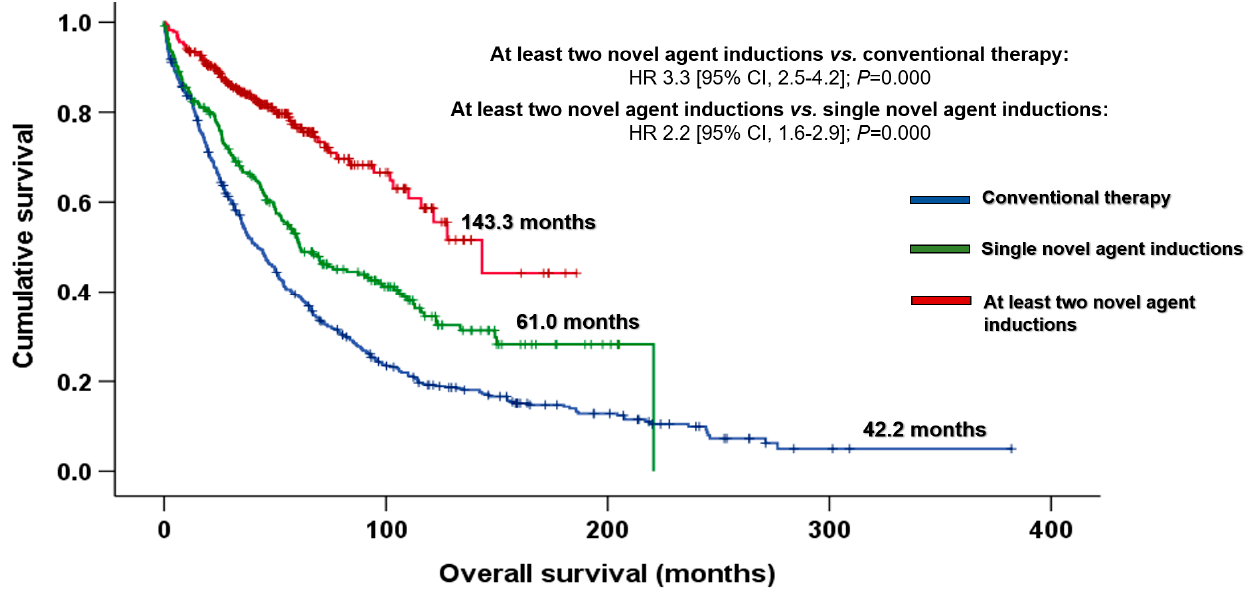
Figure 3. Overall survival by induction therapy. Abbreviations: CI: confidence interval; HR: hazard ratio.